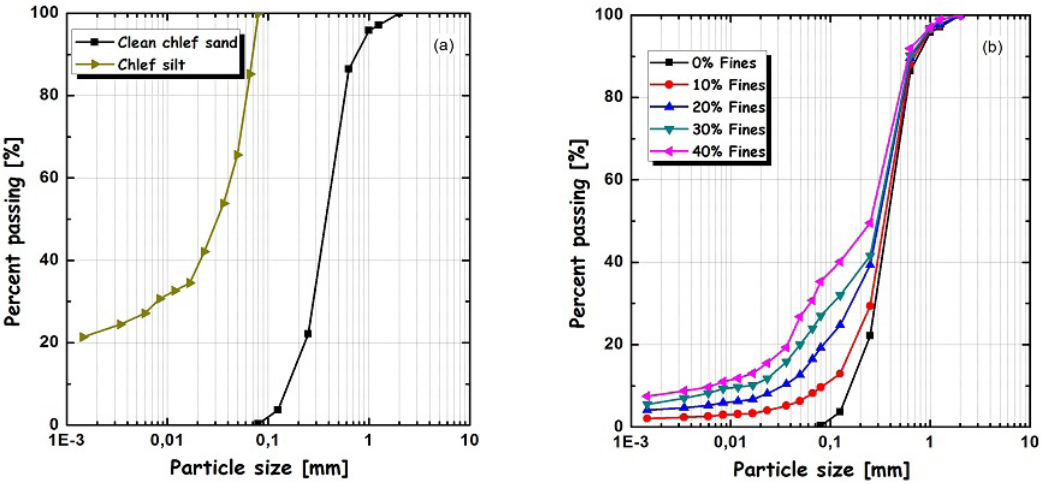
Figure 1: Grain size distribution curves of tested materials: (a) Sand and silt, (b) Sand-silt mixtures.